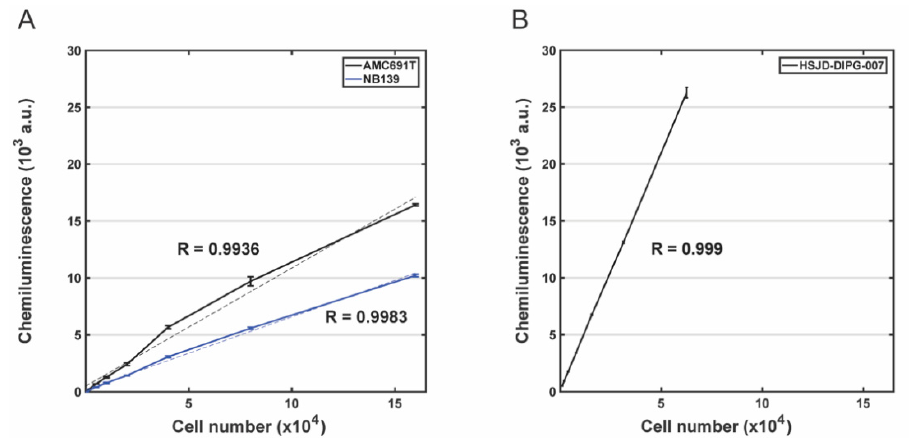
Figure 4. Correlation of tumour cell number and chemoluminescence signal using the luciferase assay for in vitro cell proliferation measurement. ( A ) Measurement of luminescence in two transduced eGFPffLuc neuroblastoma organoids (NB139 and AMC691T). ( B ) Measurement of luminescence in two transduced eGFP-ffLuc DIPG neurospheres (HSJD007). Different cell densities were seeded onto 96-well plates and the luminescence was measured after 10 min in their presence. Results are represented by average of triplicate values. R shows the linear correlation of luminescence and cell number in neuroblastoma and DIPG cells.